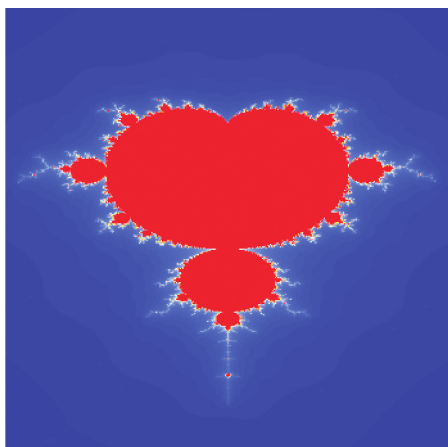
Figure 23: Quadratic Biomorph generated in Jungck-S orbit with s